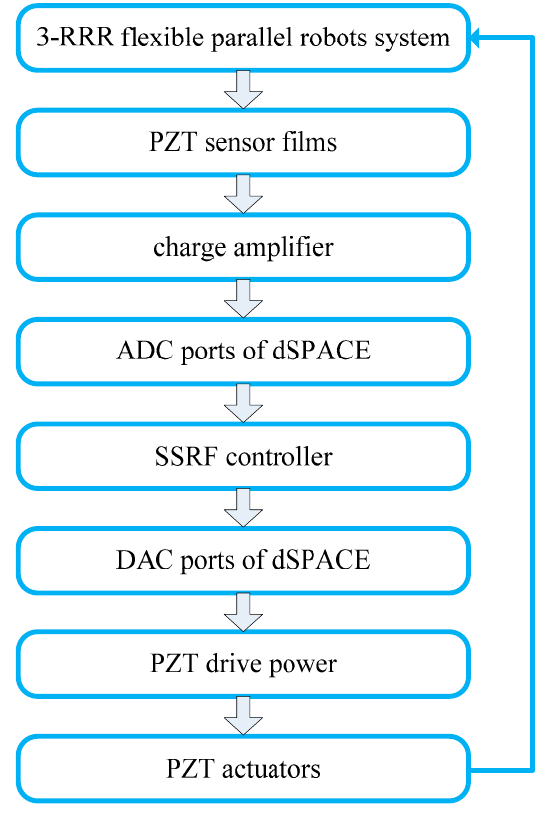
Figure 13. Experiment flow diagram.